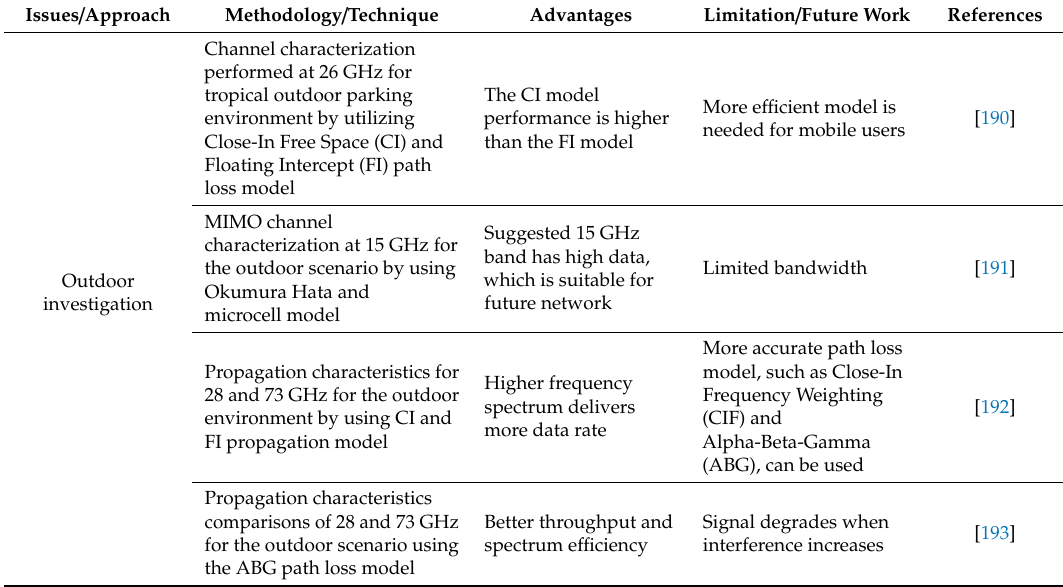
Table 4. Summary of the related work for high-spectrum